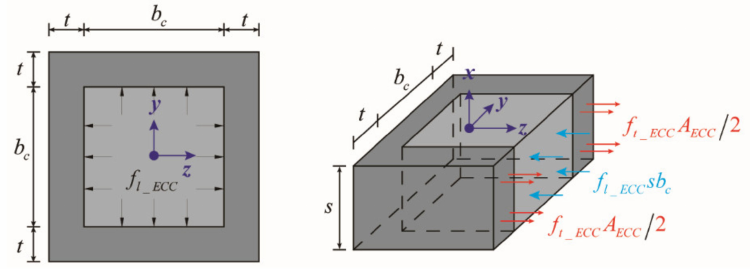
Figure 7. Forces acting on the free body of the core ECC confined by ECC